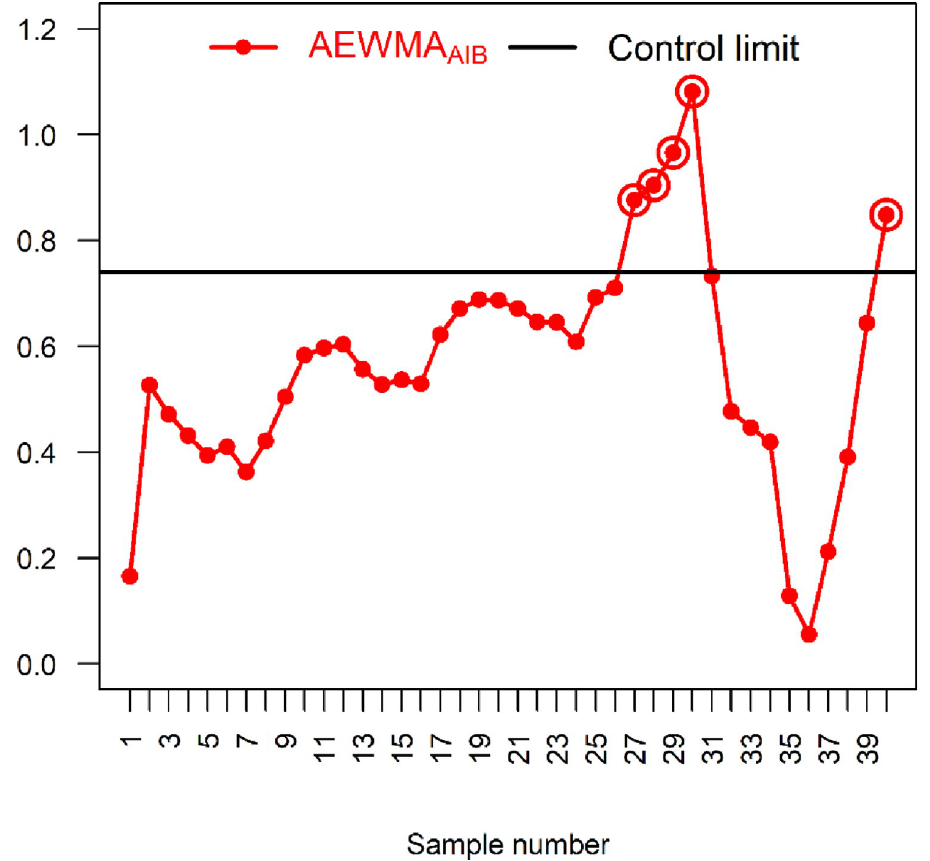
Fig 4. AEWMA AIB chart with real-life data of glass manufacturing industry using ρ = 0.905, λ = 0.1, h 0 : 7402 and ARL 0 =